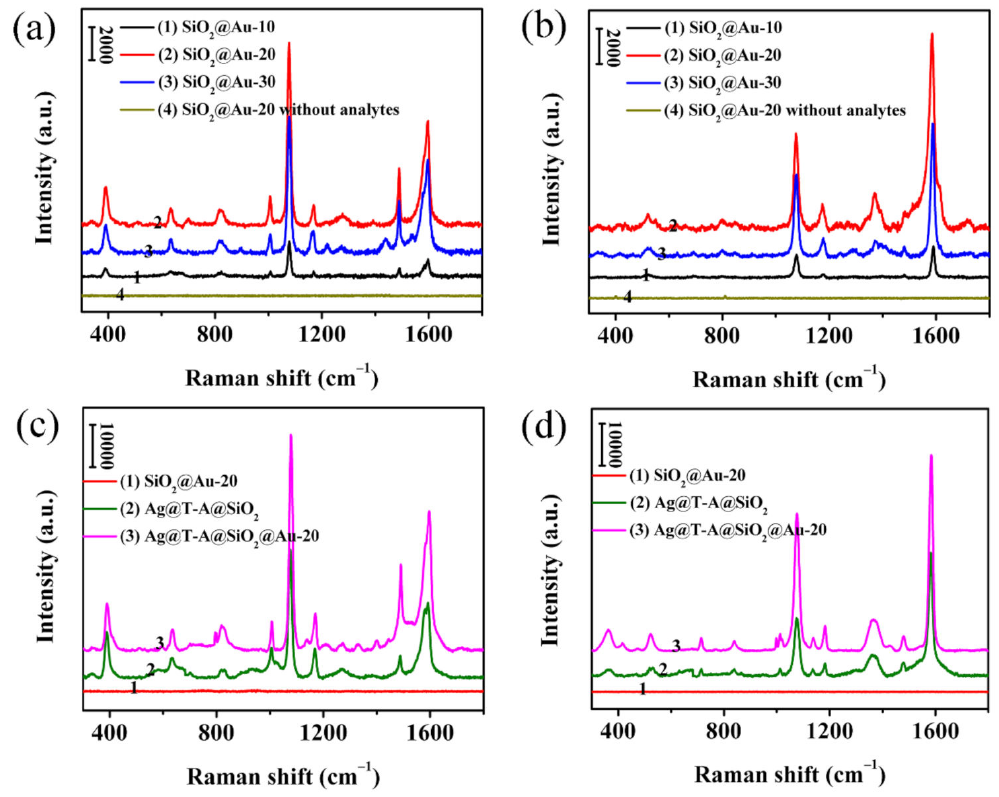
Figure 7. SERS spectra of 10 − 1 mol / L 4-MPh ( a ) and 4-MBA ( b ) adsorbed on SiO 2 @Au nanofibrous membranes; SERS spectra of 10 − 5 mol / L 4-MPh ( c ) and 4-MBA ( d ) detected on SiO 2